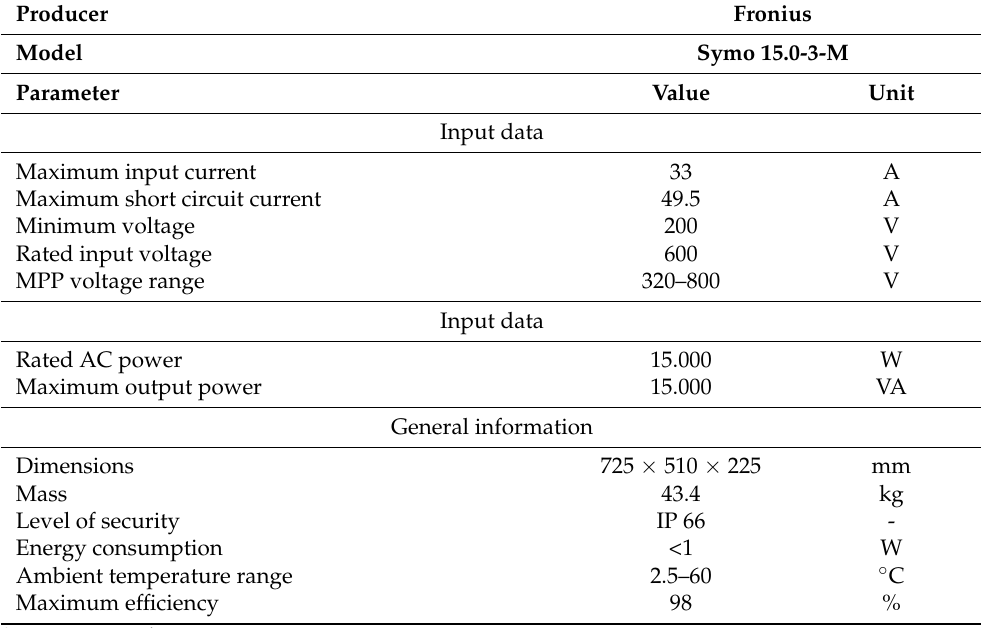
Table 2. Fronius inverter